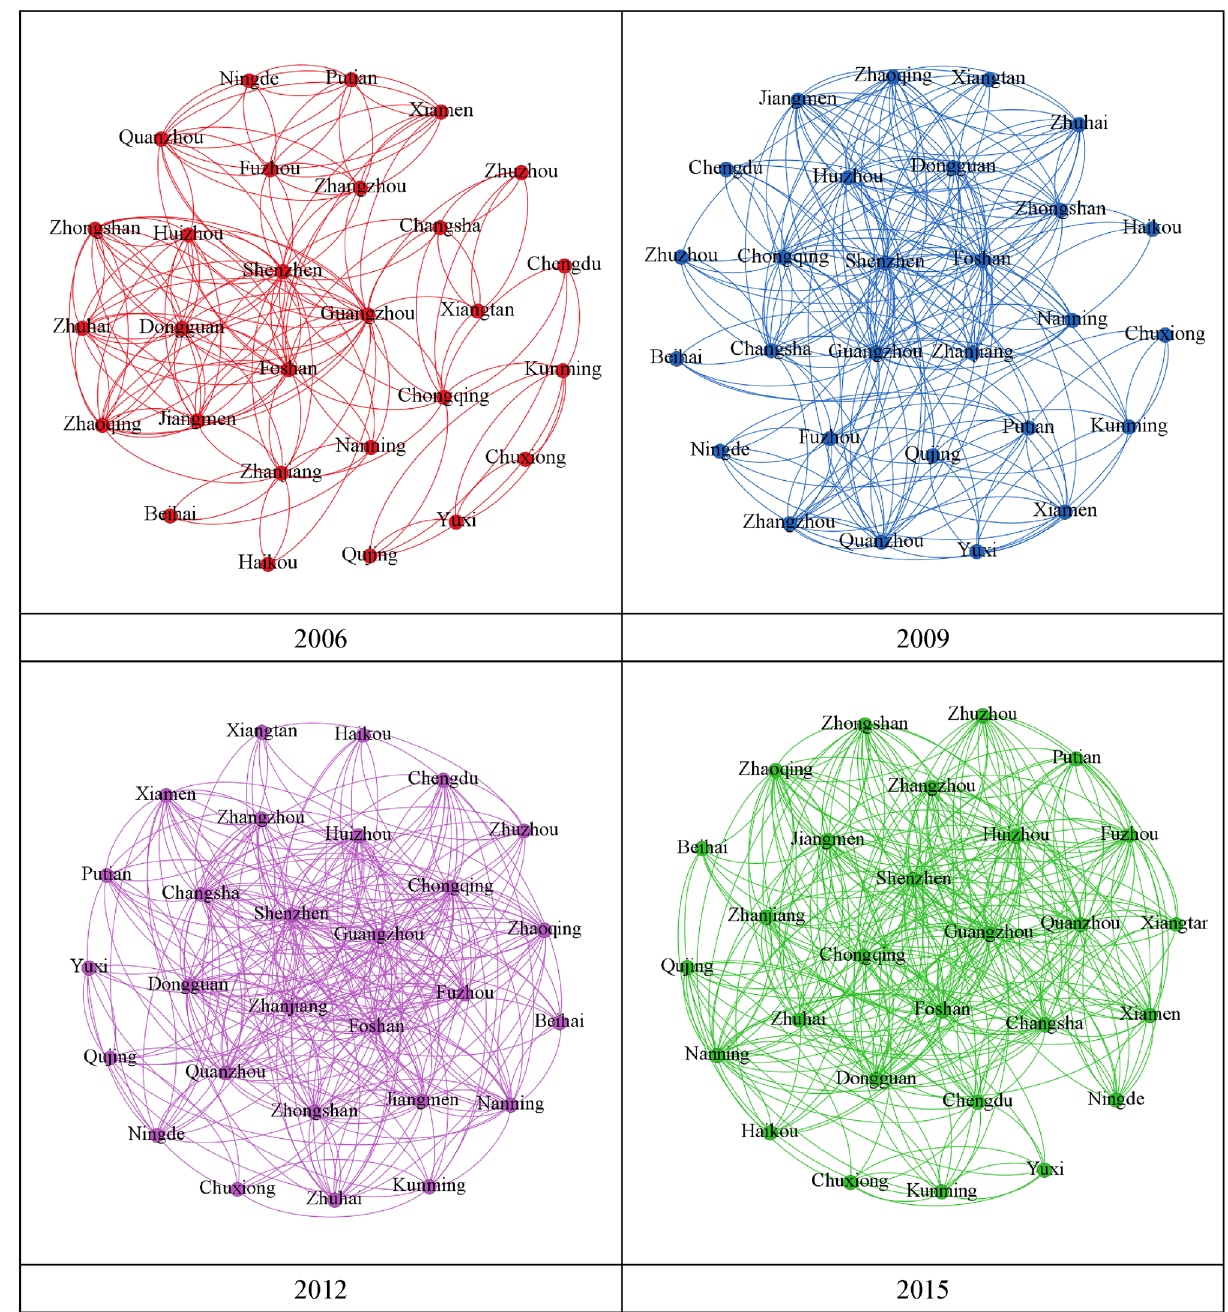
Figure 2. The evolution of the traffic correlation network structure in the Pearl River Delta (2006, 2009, 2012,